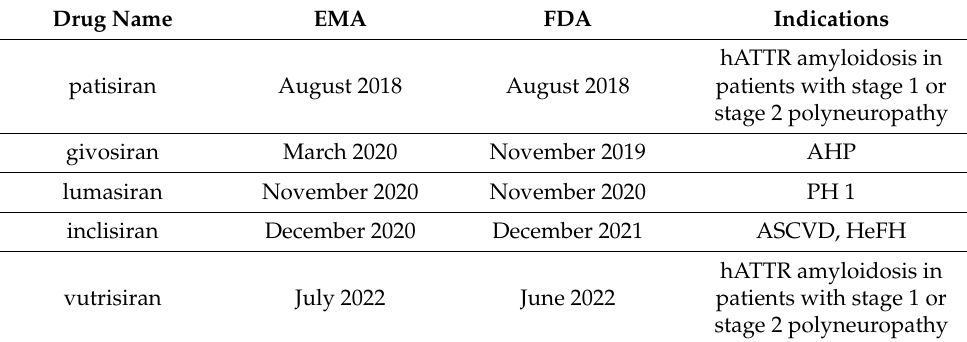
Table 1. siRNA drugs approved by EMA/FDA. Drug